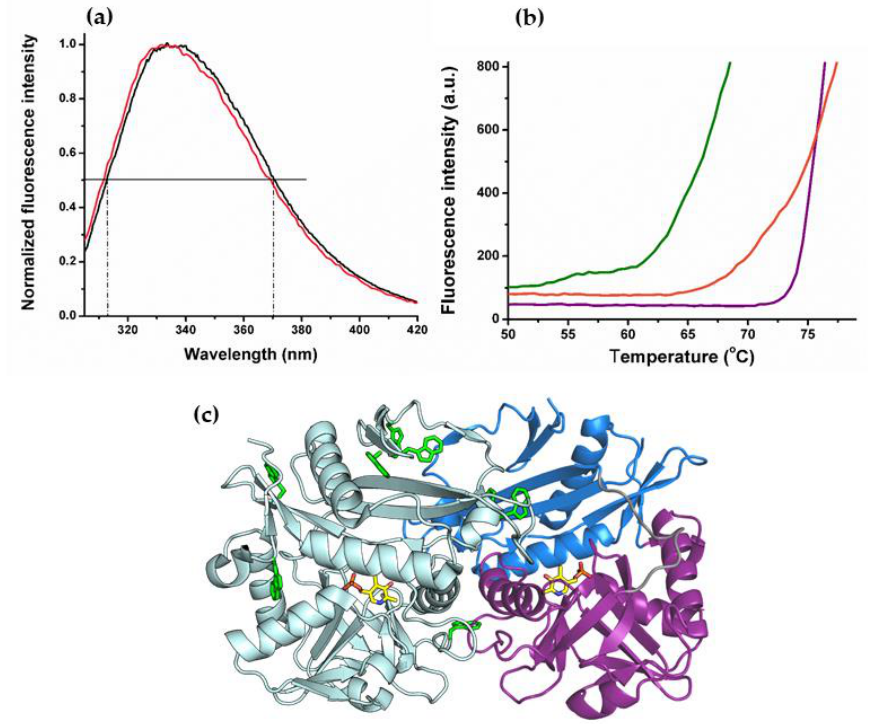
Figure 4. Thermal unfolding of TaTT studied by using its intrinsic tryptophan fluorescence. ( a ) Fluorescence spectra of 0.1 mg/ml TaTT in the PLP form in 50 mM phosphate buffer, pH 8.0, containing 50 mM NaCl, (black) and in the presence of 30% methanol (pink) at 50 °C. Intensities at 313 nm and 370 nm correspond to the half of the maximum of the TaTT fluorescence spectrum. ( b ) Light scattering accompanying thermally-induced unfolding of TaTT in Na-phosphate buffer (purple) or the presence of 15% DMSO (orange) or 15% methanol (olive). ( c ) Model of the functional dimer of TaTT (PDB ID: 6GKR). Two subunits forming the dimer are shown. In the right subunit, the small domain is colored blue, the large domain is colored purple; in the left subunit, tryptophan residues are shown in green. PLP molecules are colored yellow.